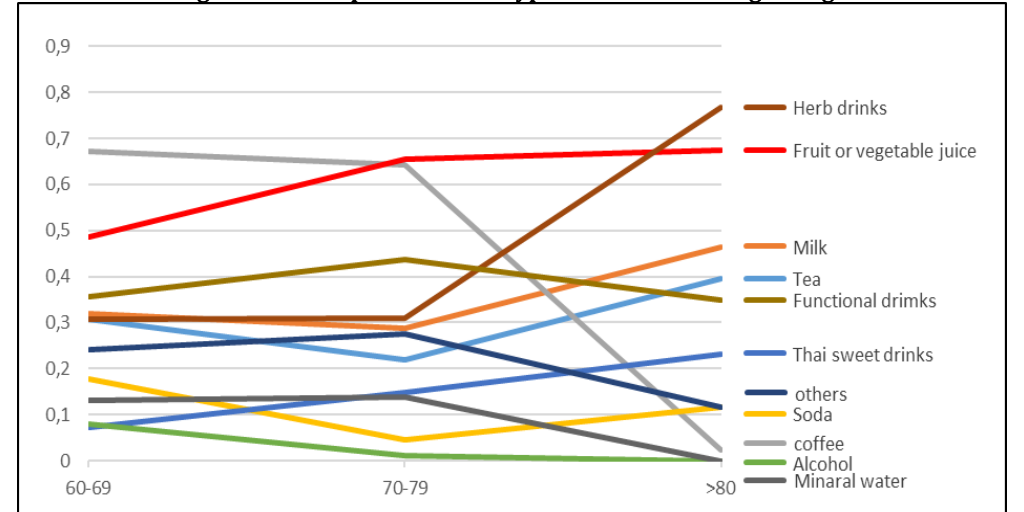
Figure 1: Mean plot between type of drink and range of